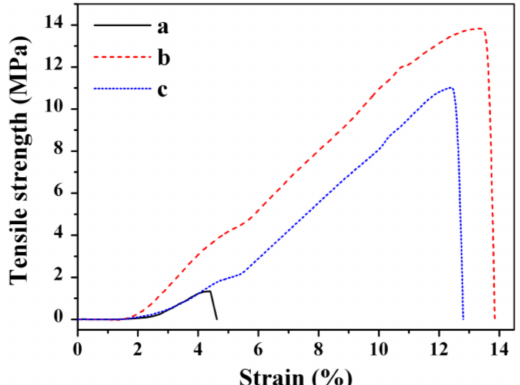
Figure 6. The tensile–strain curves of the films (a) PCNC, (b) CNC_TiO 2 , and (c) CNC_TiO 2 _TR. Table 1. Mechanical properties of the obtained spherical cellulose crystal-based films. Sample Tensile Strength (MPa) Strain (%) Young’s Modulus